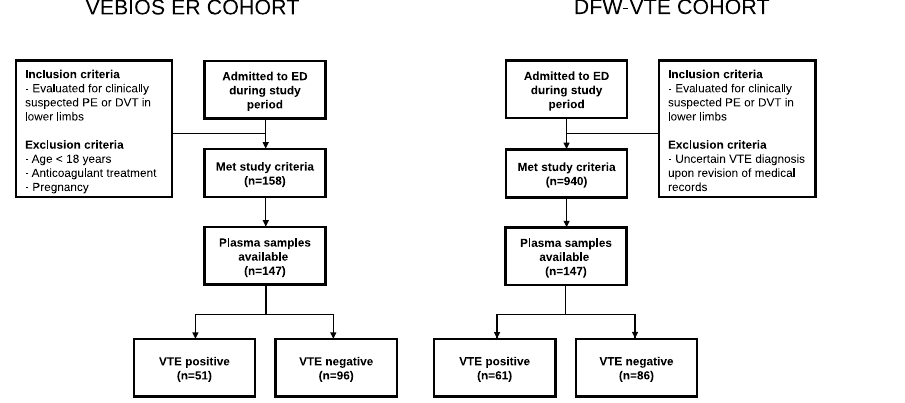
Fig 1. Flow chart describing inclusion of study